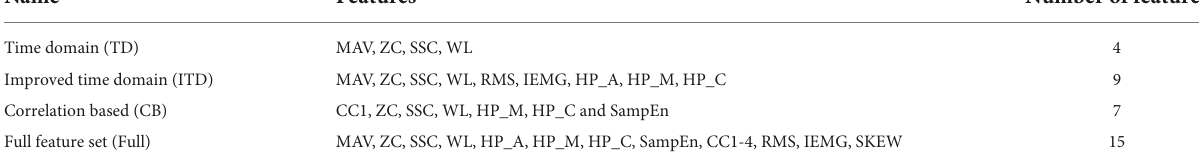
TABLE 1 Selected feature sets and their containing features.